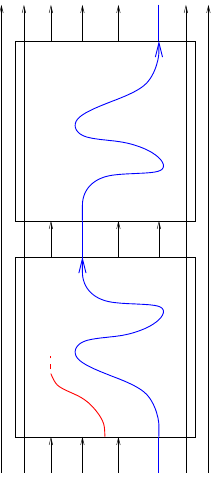
Figure 6: Doubling a trap yields a